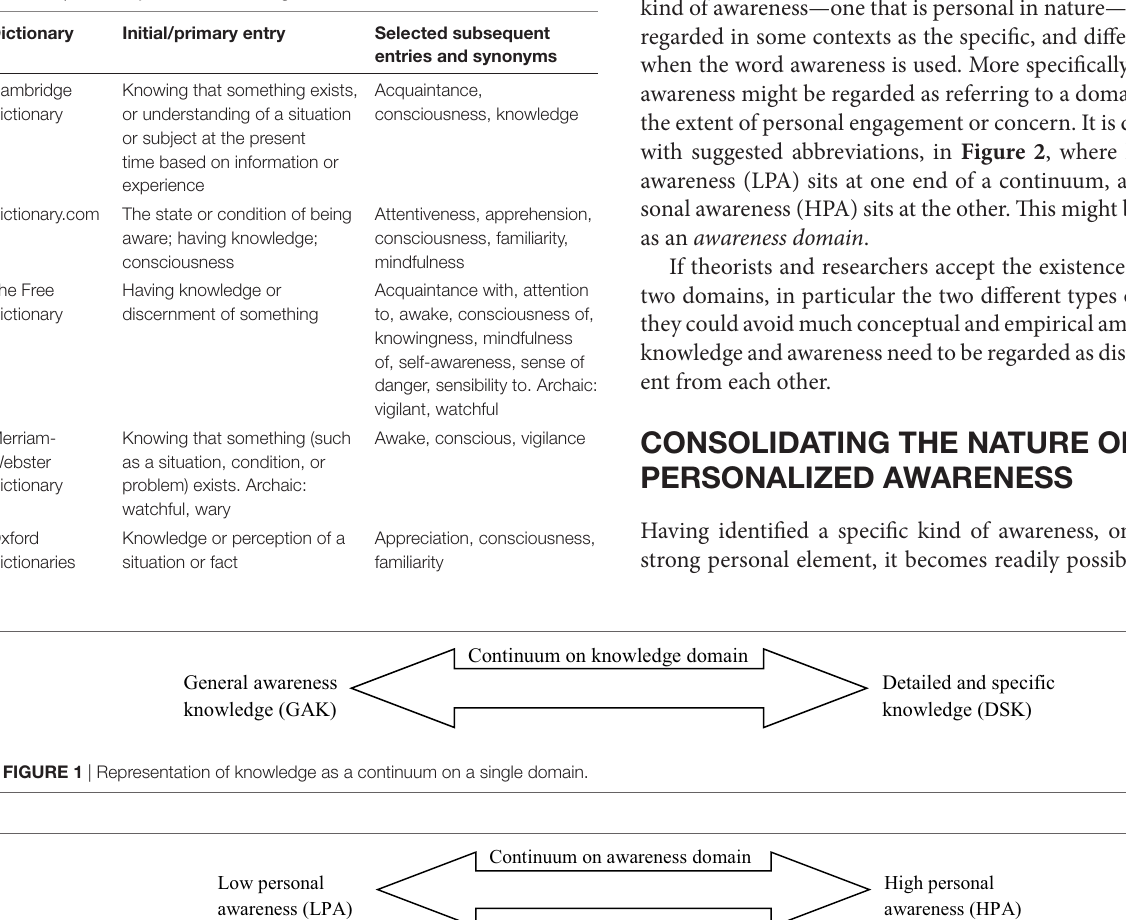
tAble 2 | Dictionary entries concerning awareness.